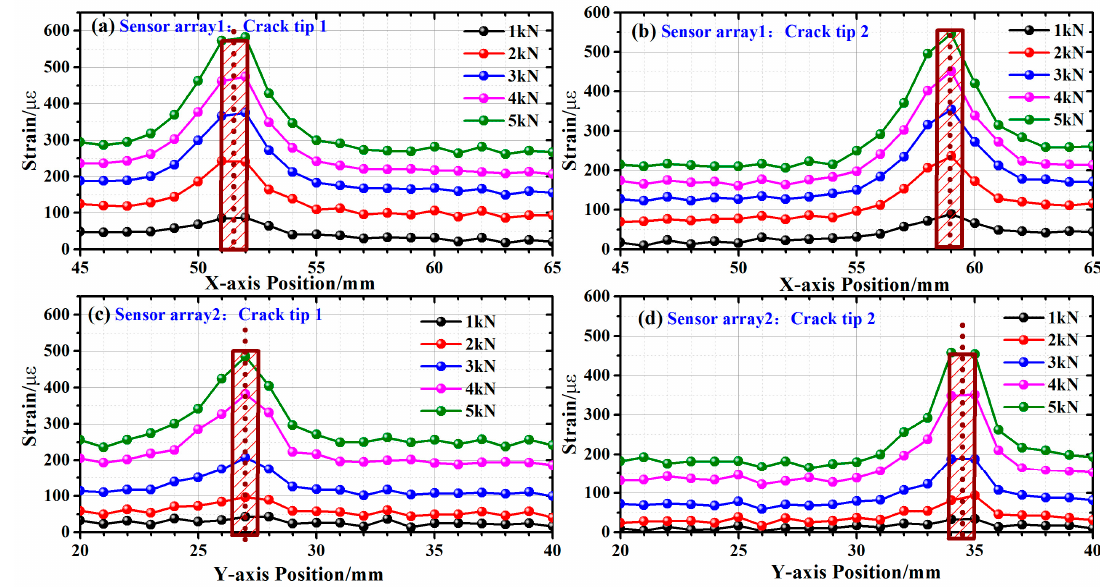
Figure 12. Inclined-crack sensing with 1kN-5-kN load applied along ( a , b ) the x -axis; ( c , d ) the y -axis.